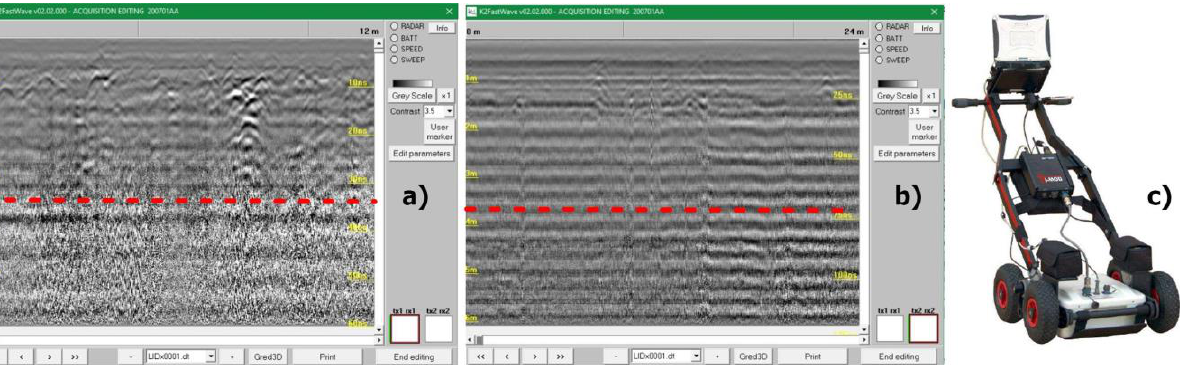
Figure 5. K2 Fastwave sw acquiring data. During crawls along the profiles, reflections caused by subsoil’s discontinuities are represented in real time. The horizontal axis reproduces the antenna advance’s direction, while the vertical axis represents pulse penetration’s direction in nanoseconds. ( a ) Radargram from 600 MHz antenna. ( b ) Same profile recorded with 200 MHz antenna. The difference in terms of resolution and investigation’s depth is noticeable; ( c ) IDS HiMod.